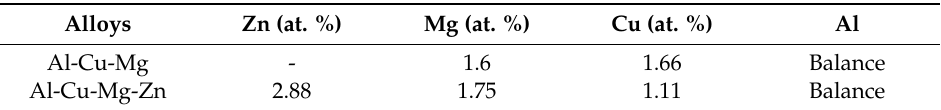
Table 1. Chemical composition of the